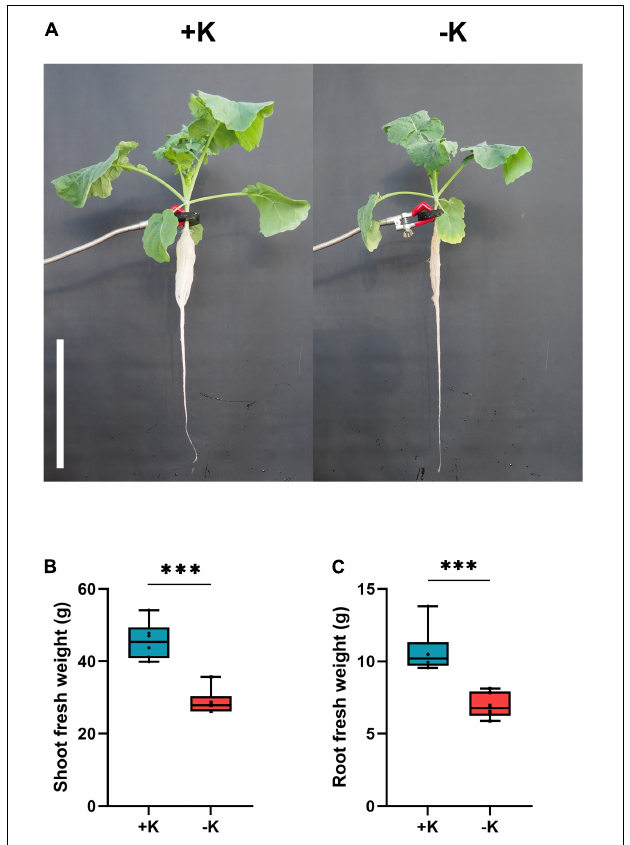
FIGURE 1 | Influence of K deficiency on rapeseed growth and development. (A) Representative picture of K-sufficient (+ K) and K-starved plants (–K); (B) shoot fresh weight and (C) root fresh weight. Plants were grown in a hydroponic culture under either –K (0 mM) or + K (2 mM). Roots and shoots were harvested after 14 days of K deprivation. Asterisks denote the significant level of the difference according to t -test ( ∗ p < 0.05, ∗∗ p < 0.01, and ∗∗∗ p < 0.001, n = 6). The scale bar represents 25